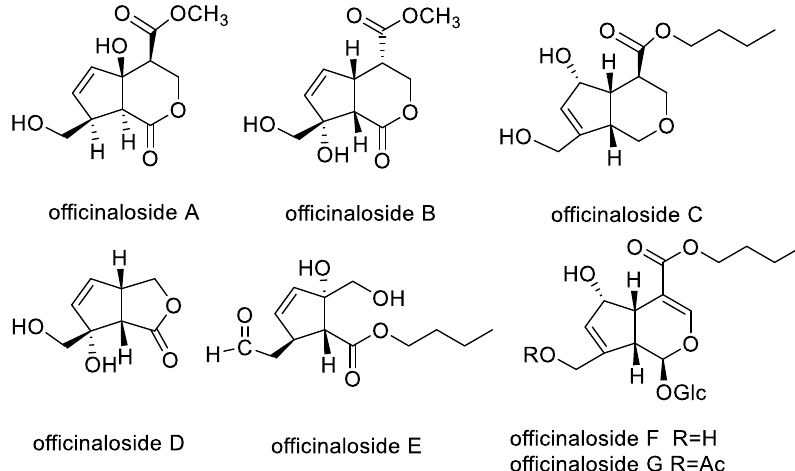
Figure 1. Chemical structures of officinaloside A – G.